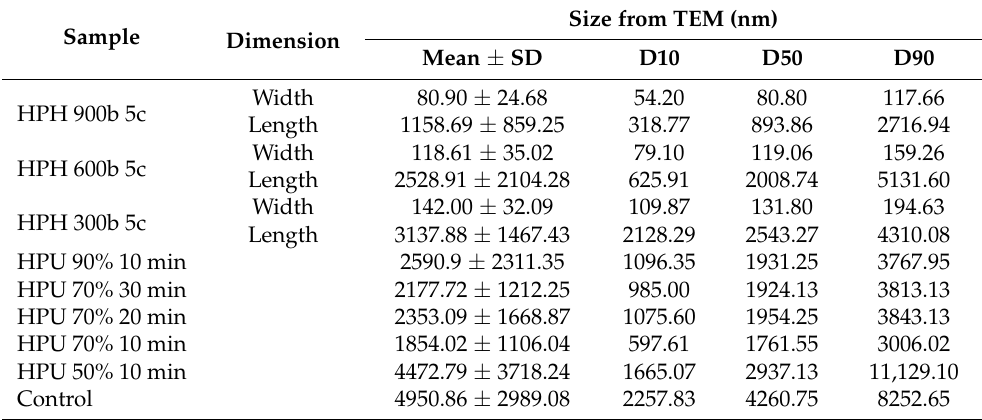
Table 1. Cocrystal size as measured from TEM